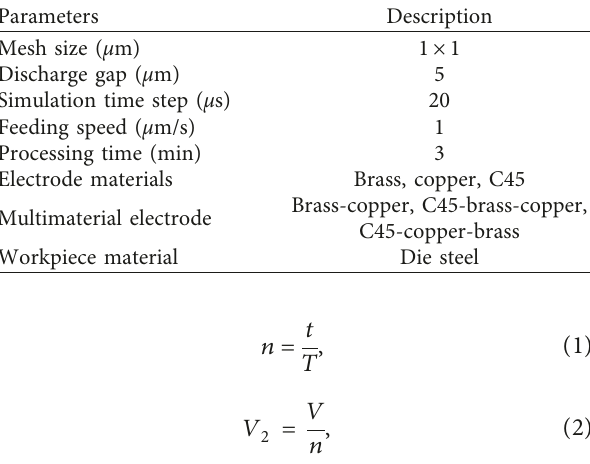
Table 1: Basic parameters of MATLAB